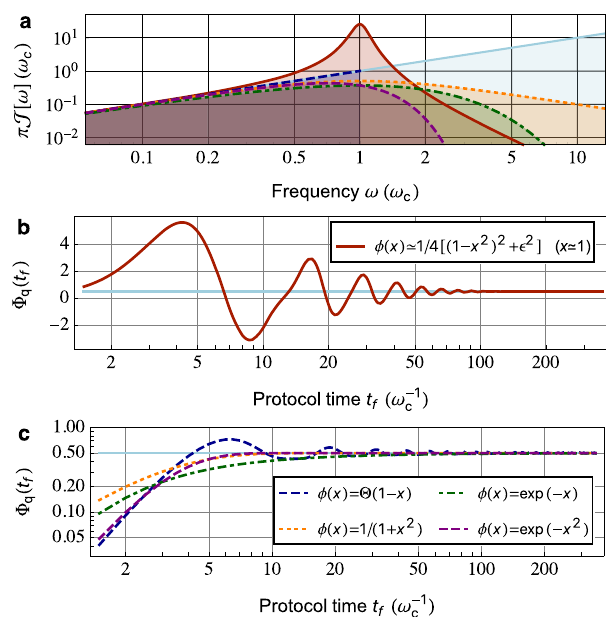
Fig. 5 Crossover dynamics of the Hahn-echo quench phase shift (QPS) Φ t f ) for environments that are Ohmic at low frequencies. For practical q ( applications, the crossover timescale at which the QPS approaches the asymptotic power-law behavior (c.f. Eq. (29)) becomes important. This timescale depends on high-frequency deviations in the bath spectral function J ½ ω (cid:5) from power law; plotted here are two generic scenarios for this crossover dynamics. As shown in ( a ), we consider bath spectral functions that are asymptotically Ohmic (i.e., proportional to frequency) at low frequencies. b Crossover dynamics for QPS with spectral function exhibiting a narrow Lorentzian peak in the range of high frequencies, i.e., (cid:1) (cid:3) 2 þ Γ 2 J ½ ω (cid:5) (cid:7) αω 3 = 4 π ½ ω (cid:2) ω (cid:5) for ω ≃ ω c (red solid curve in ( a )). For c min c narrow peak with linewidth 2 Γ min = ω c ¼ 0 : 2 < 1, the crossover timescale is given by Γ (cid:2) 1 . c QPS for spectral functions that are Ohmic at low min frequencies with a simple UV cutoff. In this case, the crossover time is given by inverse of the cutoff frequency ω (cid:2) 1 , and is independent of details c about the cutoff. Cutoff functions ϕ x ð Þ used: step-function (dashed blue), Lorentzian (dotted orange), exponential (dot-dashed green), and Gaussian cutoff (dashed purple curve). We assume α = 1 in all panels. See the main text for speci fi c forms of J ½ ω (cid:5) used in ( b ) and ( c